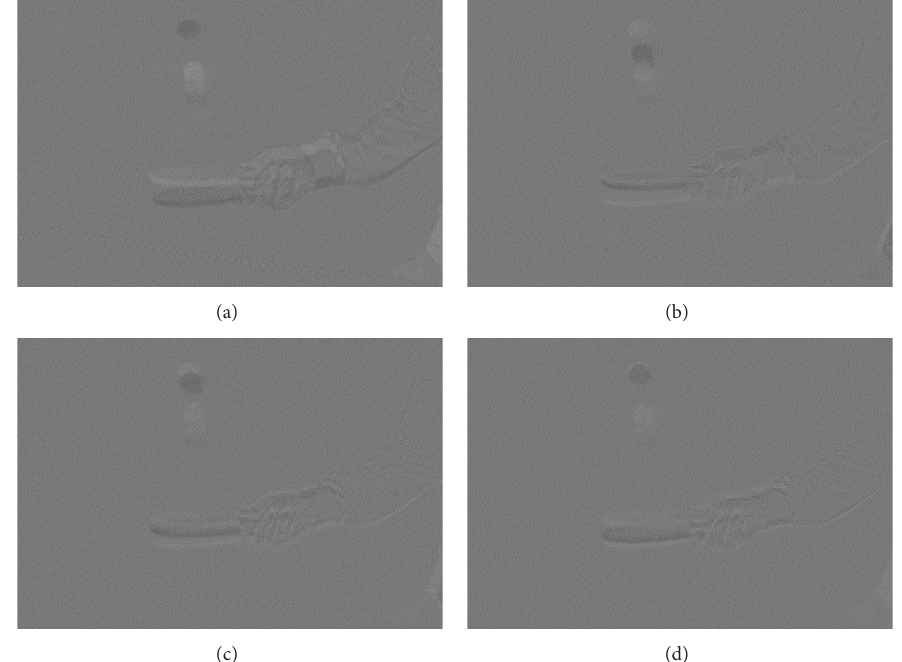
Figure 4: (a) Δ -frame from Frame 6 in 𝑈 band, (b) R-frame from Frame 2 in 𝑈 band, (c) R-frame from Frame 3 in 𝑈 band, and (d) R-frame from Frame 4 in 𝑈